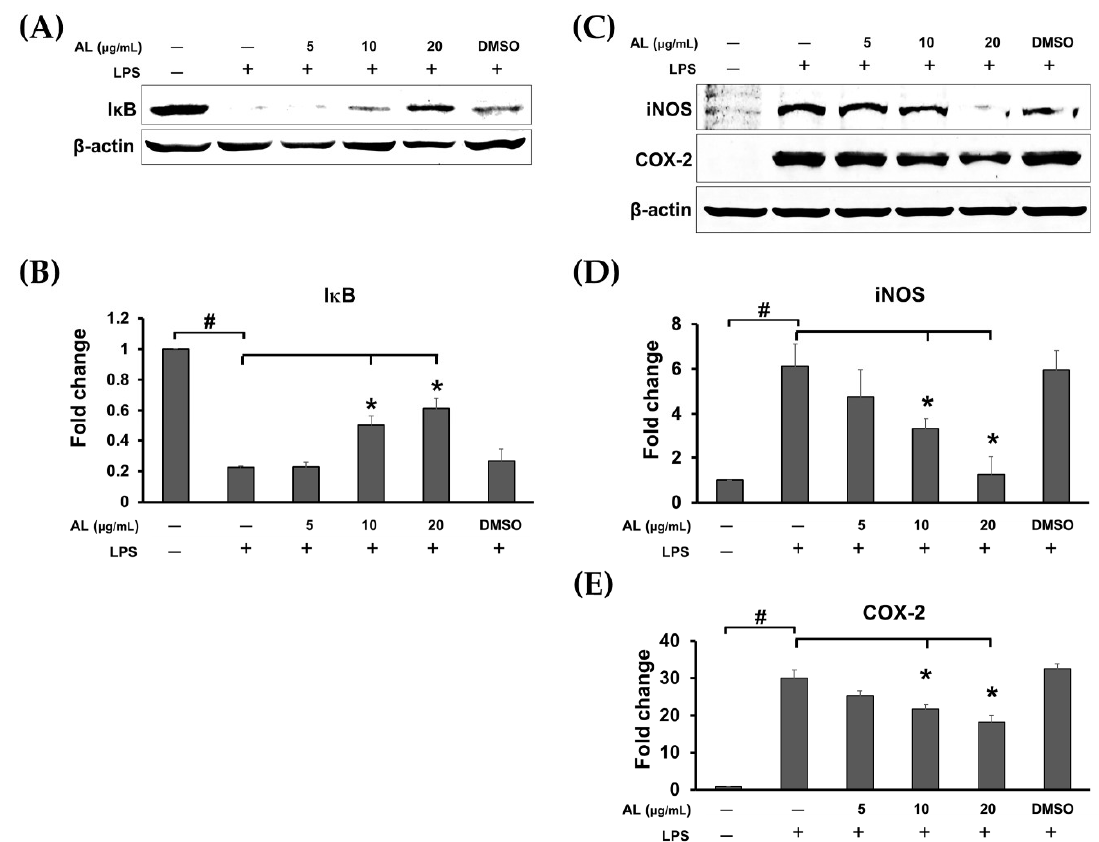
Figure 5. ( A ) Western blot analysis for the inhibitory effects of AL extract on the degradation of IκB; ( B ) quantitative analysis for IκB; ( C ) Western blot analysis for the inhibitory effects of AL extract on the protein expression level of iNOS and COX-2; ( D ) quantitative analysis for iNOS expression level; ( E ) quantitative analysis for COX-2 expression level. Beta actin (β-actin) was detected and used as an internal control. Data are representatives of three replicates and shown as mean ± SD; # p < 0.05 (compared to the untreated control) or * p < 0.05 (compared to the LPS-treated group).